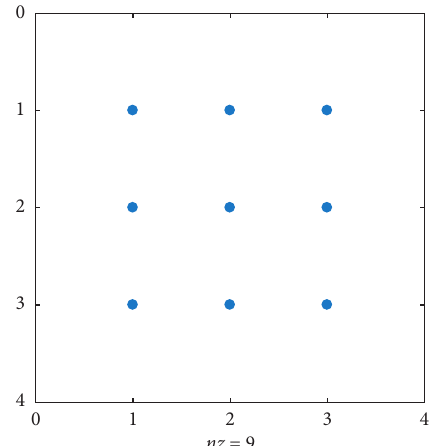
Figure 8: Receive array configuration.